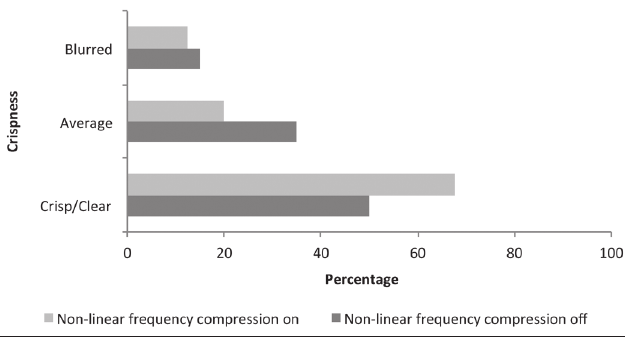
Fig. 4. Participants’ perception of the crispness of music with NFC off versus NFC